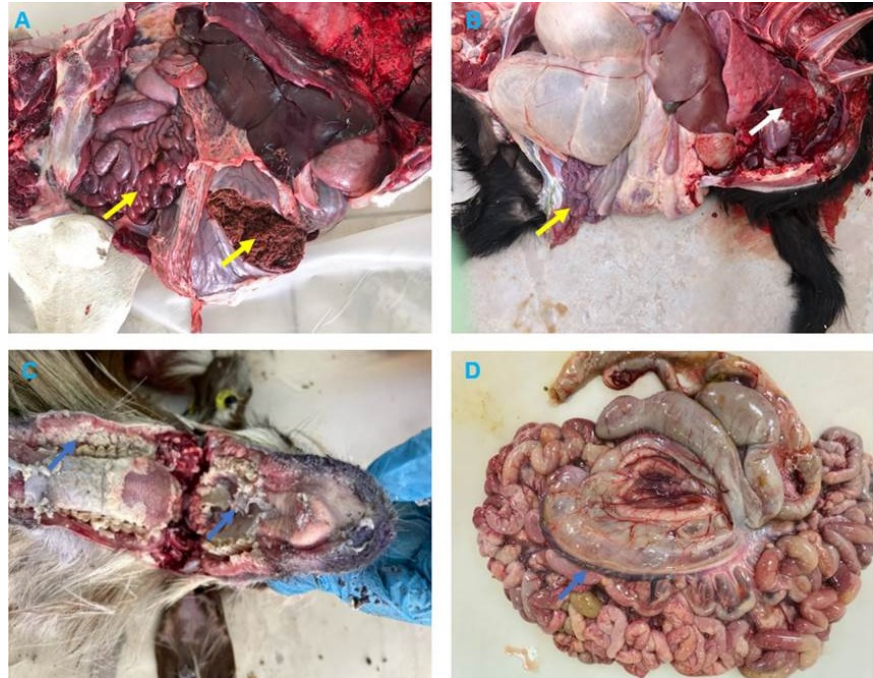
Figure 3. Necropsy findings in Dama Gazelle and Goats with Peste des petits ruminants (PPR). ( A ) Dama Gazelle digestive system shows hemorrhagic gastroenteritis (yellow arrows). ( B ) Goat, lung, showing bronchopneumonia, with consolidation in the middle and apical lobes of the right lung (white arrow), intestine with hemorrhagic enteritis (yellow arrow). ( C ) Goat, showing erosion on the buccal cavity, gums, and dental pad with whitish covering materials (blue arrows). ( D ) Goat, showing enlarged congested and edematous mesenteric lymph nodes (blue arrow).